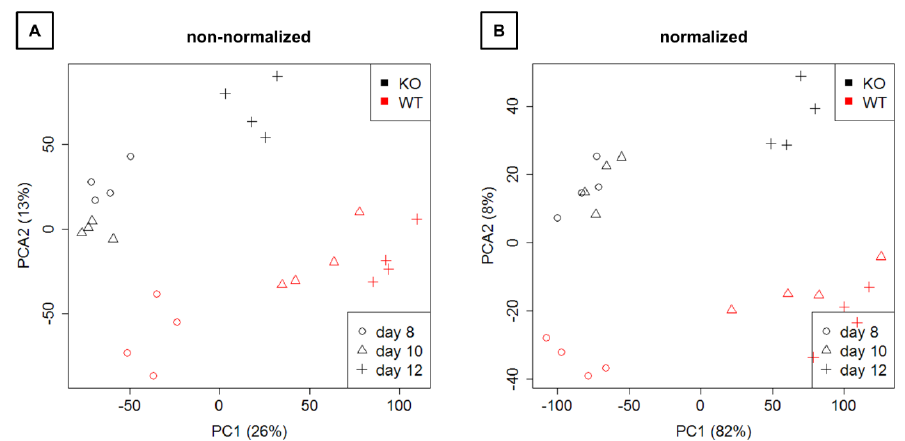
Figure 4. Representation of the expression data on the first two principal components. ( A ) Raw next-generation sequencing (NGS) data are shown. ( B ) Normalized data are depicted. KO: knockout, WT: wild type.